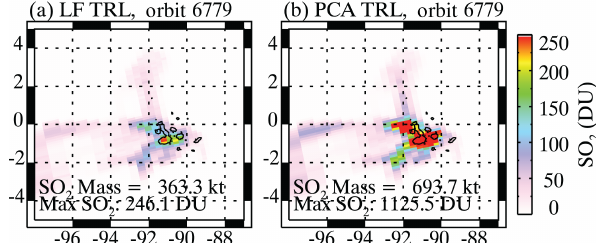
Figure 6. (a) OMI LF SO 2 retrievals assuming a lower tropospheric (TRL) SO 2 profile over the Galápagos Islands, from orbit 6779 on 23 October 2005, after the eruption of Sierra Negra volcano on the previous day. (b) Same as (a) but for OMSO2VOLCANO (PCA) TRL